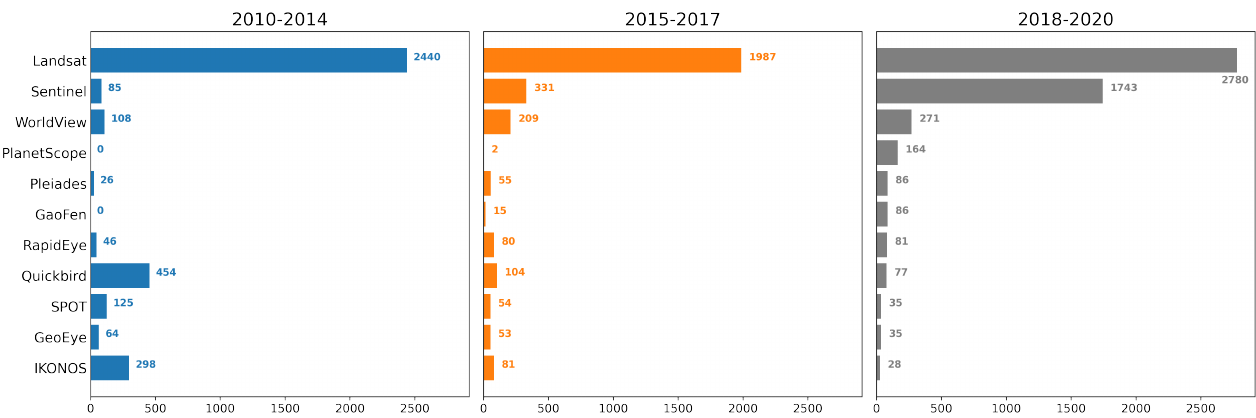
Figure A1. Number of articles in which each satellite appears in the Scopus database, depending on the years.